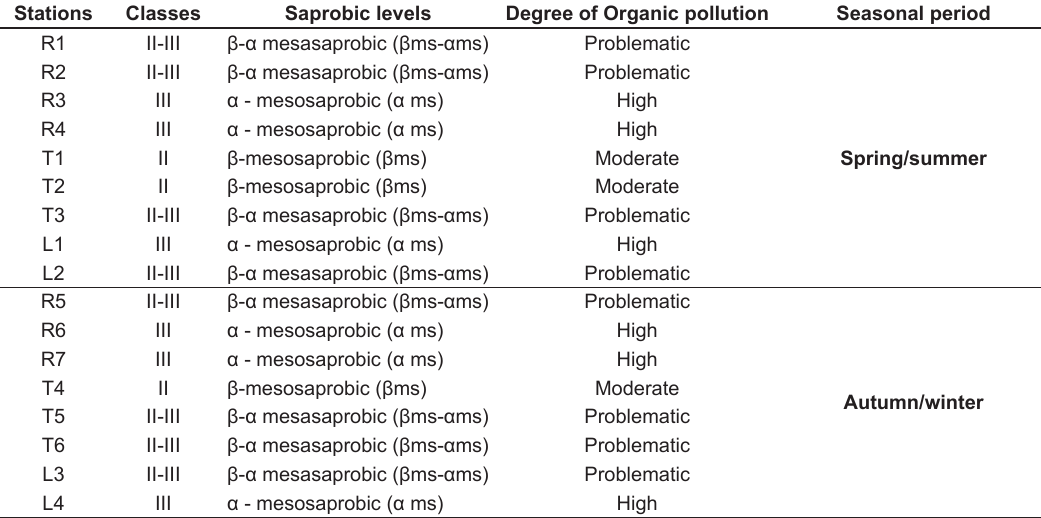
Table 4. Saprobic levels of the sampling stations studied in the Itupararanga